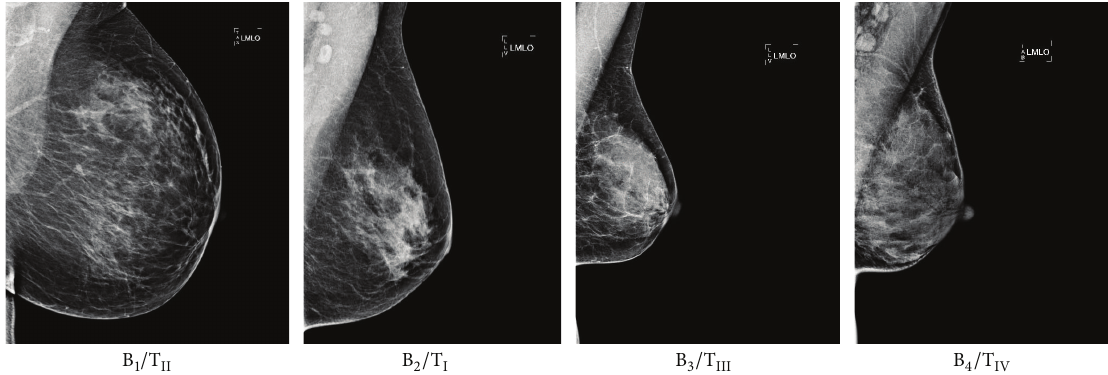
Figure 2: Example mammographic images with BI-RADS (B) density categories from low to high and their equivalent according to Tab´ar (T) risk